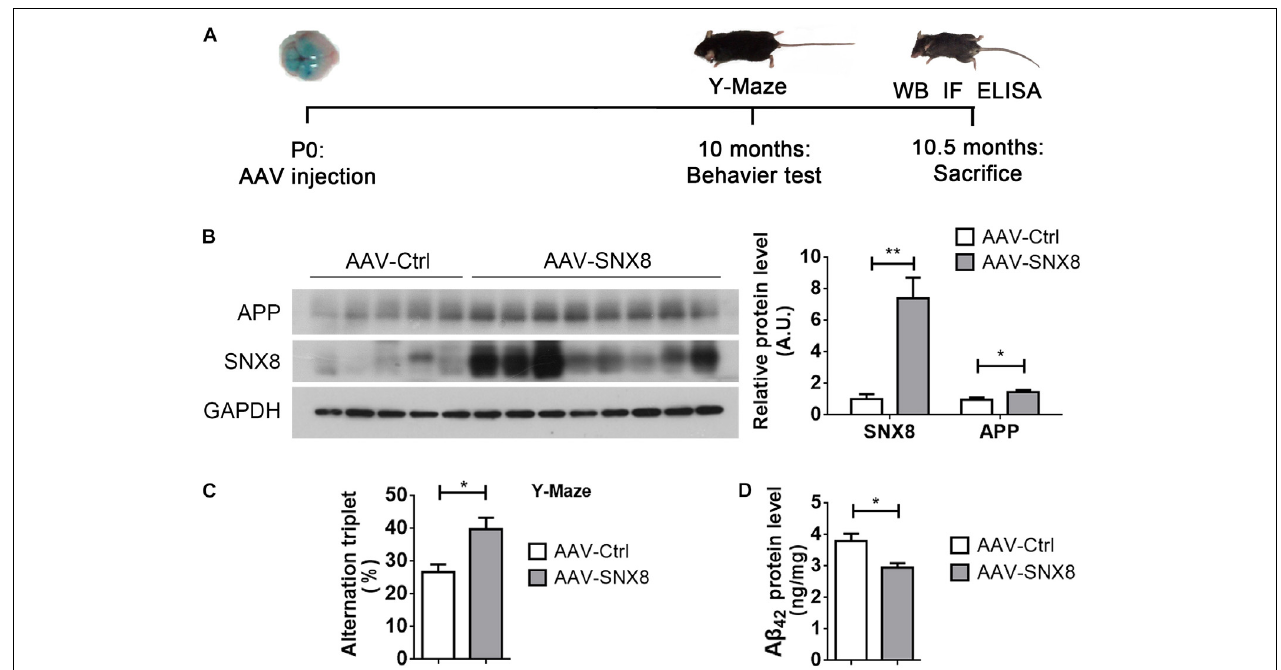
FIGURE 6 | SNX8 Overexpression Improves Short-Term Memory and Reduces A β 42 in APP/PS1 Mice. (A) A workflow diagram for AAV-SNX8 injection and subsequent analysis. (B) Equal protein amounts of hippocampal lysates from APP/PS1 mice injected with AAV-SNX8 or controls (AAV-Ctrl) were subjected to Western blotting for APP, SNX8, and GAPDH. APP and SNX8 band intensities were quantified by densitometry, and normalized to those of GAPDH for comparison (samples injected with AAV-Ctrl were set to 1.0 arbitrary unit, A.U.). AAV-SNX8, n = 8; AAV-Ctrl, n = 5. ∗ p < 0.05, ∗∗ p < 0.01, Mann–Whitney U test. (C) APP/PS1 mice injected with AAV-SNX8 and controls were evaluated for memory-related behavior in Y maze tests. Spontaneous alternations were determined between experimental groups. AAV-SNX8, n = 8; AAV-Ctrl, n = 5. ∗ p < 0.05, Mann–Whitney U test. (D) A β 42 levels in hippocampal lysates from injected mice were analyzed by ELISA. AAV-SNX8, n = 8; AAV-Ctrl, n = 5. ∗ p < 0.05, Mann–Whitney U